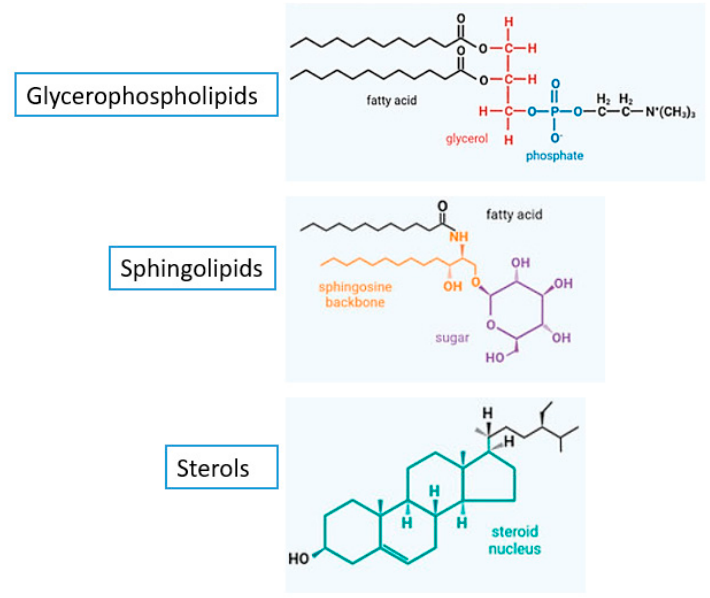
Figure 2. Representative structures of lipids present in fungal cell membranes [29]. Glycerophospholipids possess both polar glycerol and phosphate group and nonpolar hydrocarbon. Sphingolipids have a sphingosine backbone and an attached sugar. Sterols have a steroidal nucleus composed of four tightly fused carbon rings with a hydroxyl group attached to the first ring.